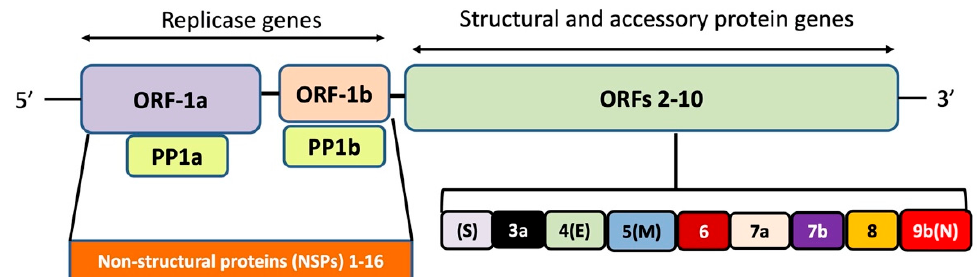
Figure 1. Genome organization of SARS-CoV-2. The polypeptides expressed by open reading frame (ORF)-1a and ORF-1b are cleaved-off to constituent components by the viral proteases papain-like protease (nsp3) and the main protease (nsp5), respectively.